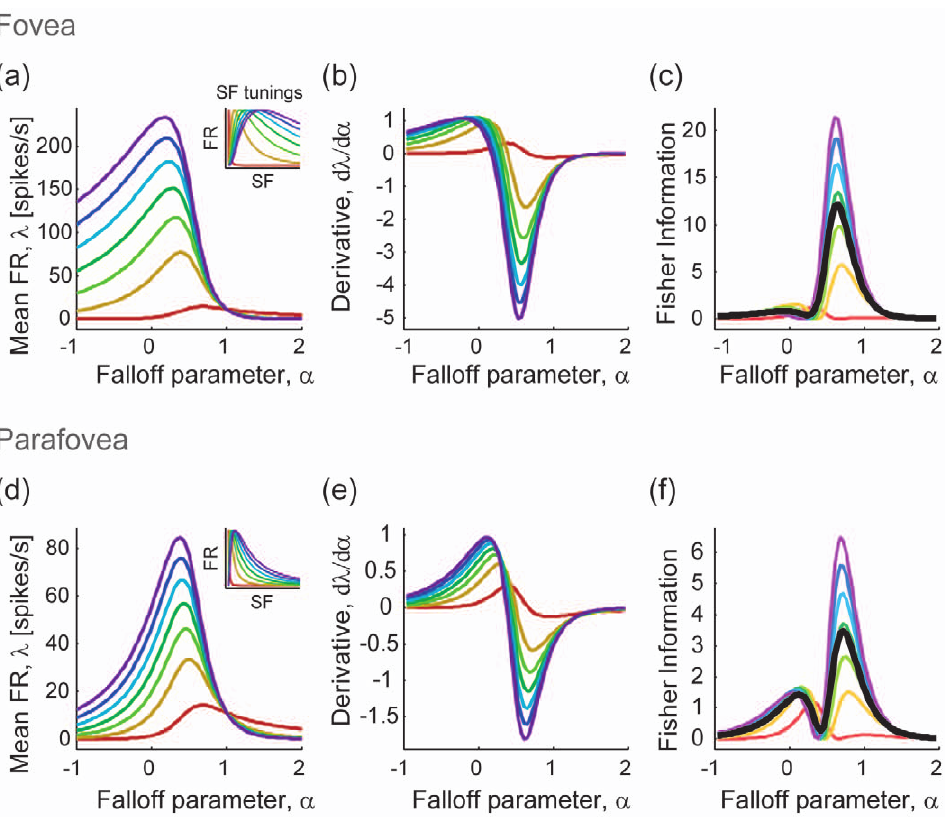
Figure 3. Derivations of Fisher information carried by neural populations. (a–c) Fovea. Preferred spatial frequencies of the units varied from 0.01 to 10 cycles/deg. (a) Hypothetical a -tuning curves (identical to Fig. 1d). Inset illustrates the spatial frequency tuning curves and the distribution of the preferred frequencies of the model neurons (same as shown in Fig. 1b). The figure shows seven example units with preferred frequencies spaced evenly from 0.01 to 10 cycles/deg (colored from red to indigo). (b) The derivative functions of the a -tuning differentiated by the falloff parameter (i.e., d l = d a ). (c) The local Fisher information of the individual units (thin colored curves) and their average (i.e., information per unit; thick black curve). Colors of curves in panels b and c are matched to those in panel a. (d–f) Same as (a–c), but computed for the parafovea, where the units’ preferred spatial frequencies varied from 0.01 to 1 cycles/deg. Seven example units, whose preferred frequencies are spaced evenly from 0.01 to 1 cycle/deg (colored from red to indigo). of Fig. 2 shows the data cited in Hansen and Hess [8]. The brown model neurons in the fovea and the parafovea (the neurons in panel a are identical to those shown in Fig. 1d). Note that their and the red curves in the figure represent the discrimination vertical scales are different. The inset figures show the spatial thresholds for the fovea and the parafovea, respectively. The right frequency tuning curves of each of seven neurons, illustrating the panel of Fig. 2 shows the discrimination thresholds computed with difference in the distributions of the peak preferred frequencies between the fovea and the parafovea. Figures 3b and e show the derivatives of the tuning functions differentiated by a (i.e., d l i = d a ). The absolute values of those derivative functions model. Because the discrimination threshold D a Thresh a ð Þ is given represent the sensitivities of the units to a slight fluctuation around particular a values. The Fisher information measures are given by computing the ratio of the derivative and the mean firing rate, as (Fig. 3f) indicates the presence of two threshold minima with the we have seen in Eq. (15). Figures 3c and f show the Fisher information carried by each individual unit and the whole population. Each of the thin colored curves in the figures represents the contribution of each unit J Local a ð Þ to the total Fisher information J a ð Þ . The thick black curves represent the information averaged over the population (i.e., J a ð Þ = N ). Notably, in the parafoveal condition the average Fisher information shows clear double peaks (the primary peak around a ~ 0 : 8 and the secondary peak around a ~ 0 : 1 ), whereas the secondary peak is almost ignorable in the foveal condition.